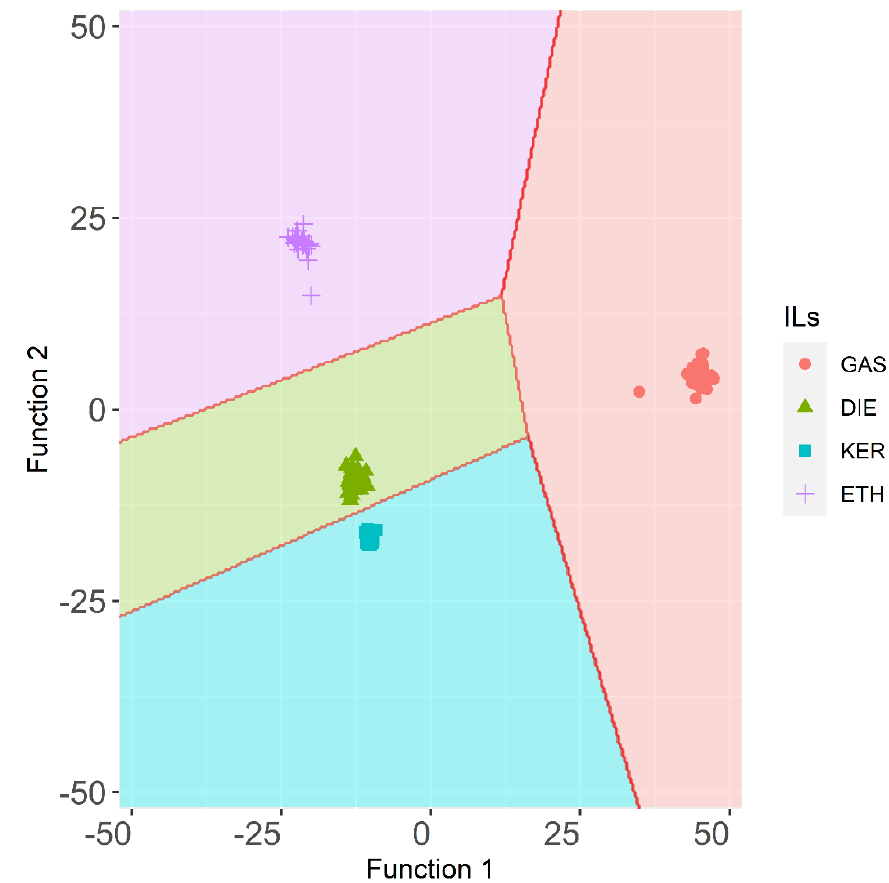
Figure 3. Territorial map for the ILR samples (training set) obtained by LDA using HS-MS eNose data ( n = 202).